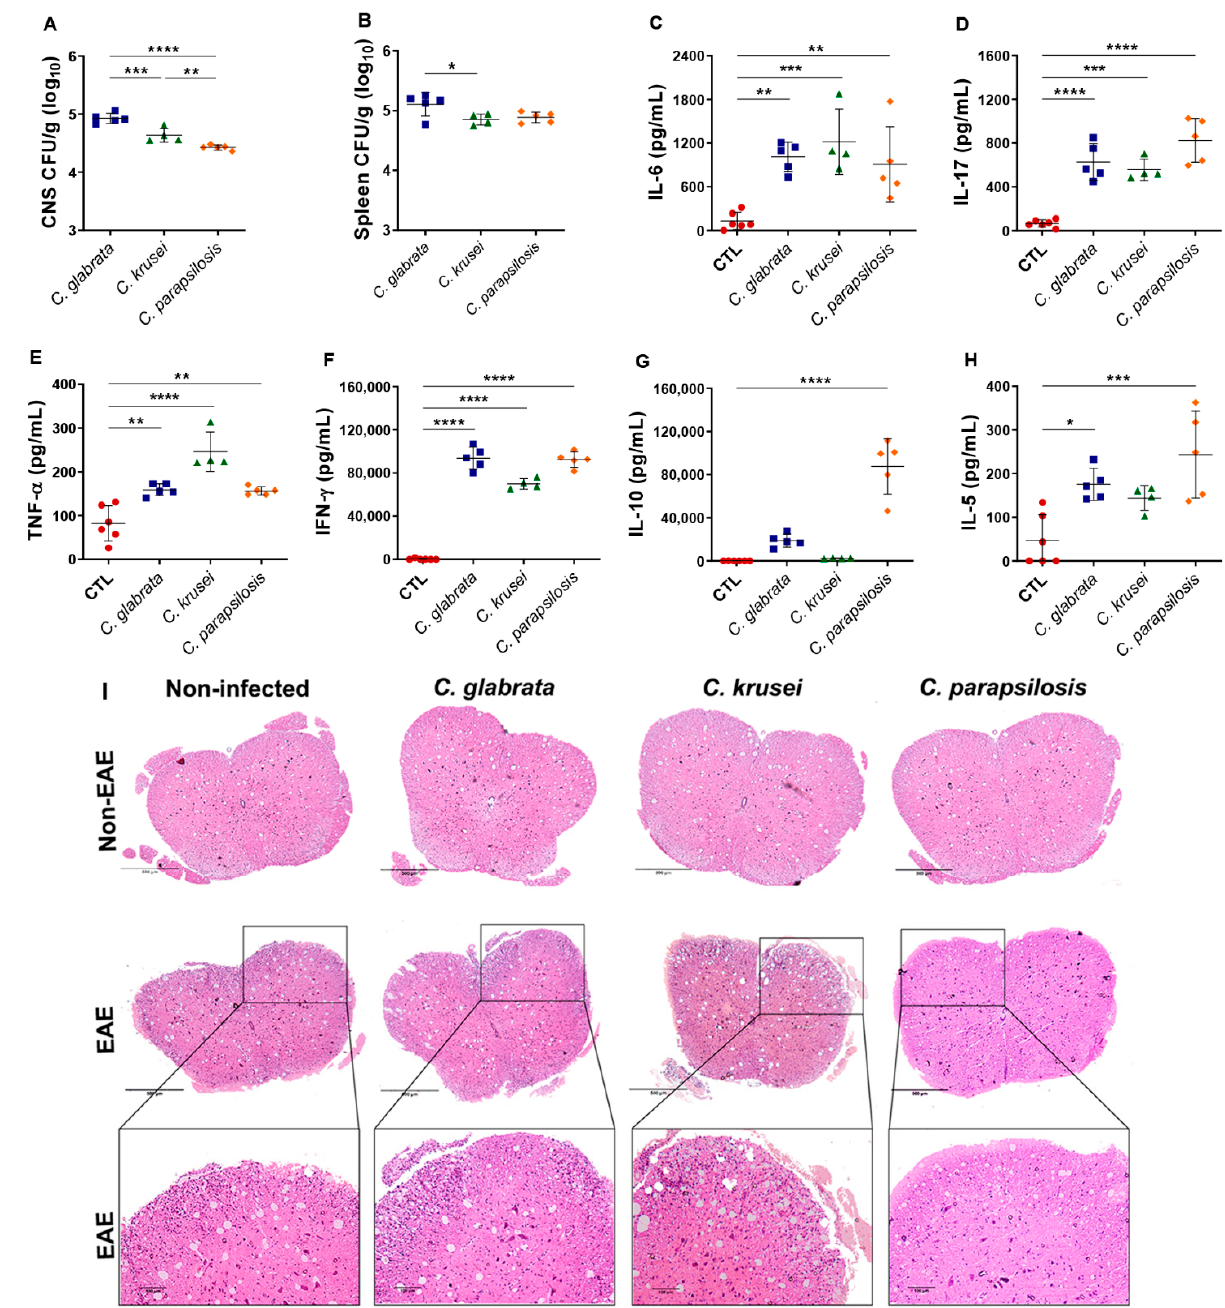
Figure 4. Effect of non- albicans Candida infection in control and EAE mice. Female C57BL/6 mice were infected with 5×10 6 viable yeasts of C. glabrata , C. krusei , or C. parapsilosis , and fungal loads in CNS ( A ) and spleen ( B ) samples were evaluated three days later. IL-6 ( C ), IL-17 ( D ), TNF- α ( E ), IFN- γ ( F ), IL-10 ( G ), and IL-5 ( H ) levels were quantified in splenic cell cultures (5 × 10 6 cells/mL) stimu- lated with concanavalin A (20 µg/mL). Representative images of the inflammatory infiltrate ( I ) ob- served in the lumbar spinal cord samples. The results are expressed as mean ± SD from one experi- ment (n = 4–6/group) and * p < 0.05, ** p < 0.01, *** p < 0.001, and **** p < 0.0001.